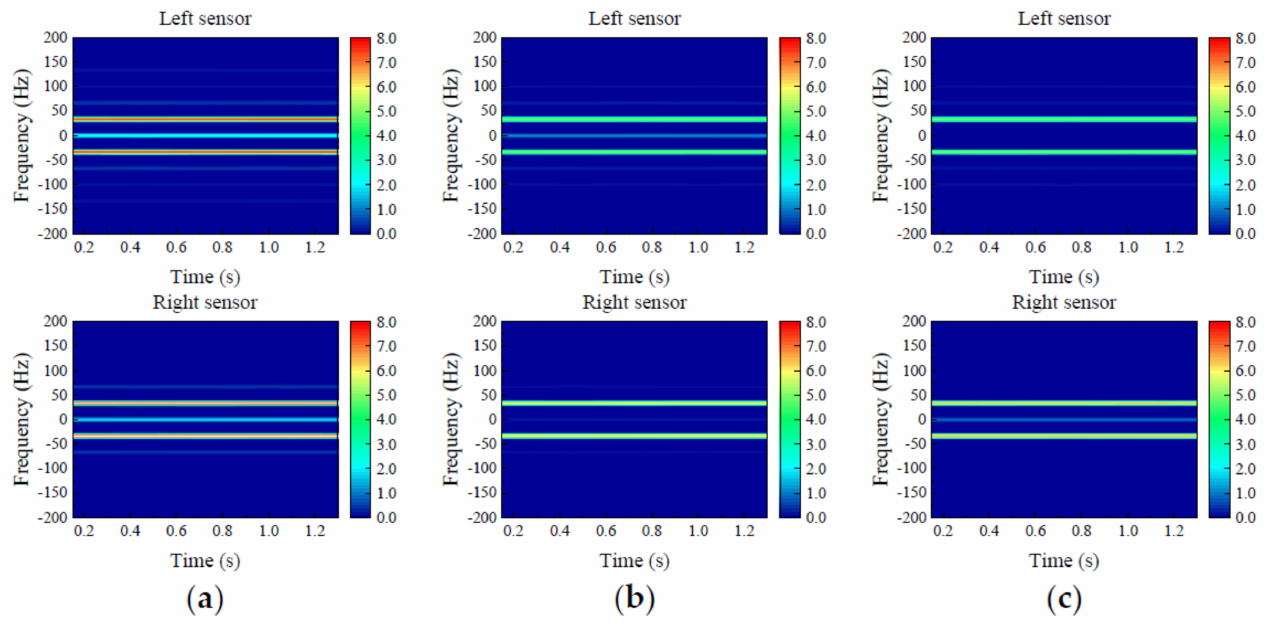
Figure 22. Time-frequency diagram of imbalanced faults: ( a ) value of imbalance 2.5 × 10 − 5 kg · m; ( b ) value of imbalance 5 × 10 − 5 kg · m; ( c ) value of imbalance 10 × 10 − 5 kg ·